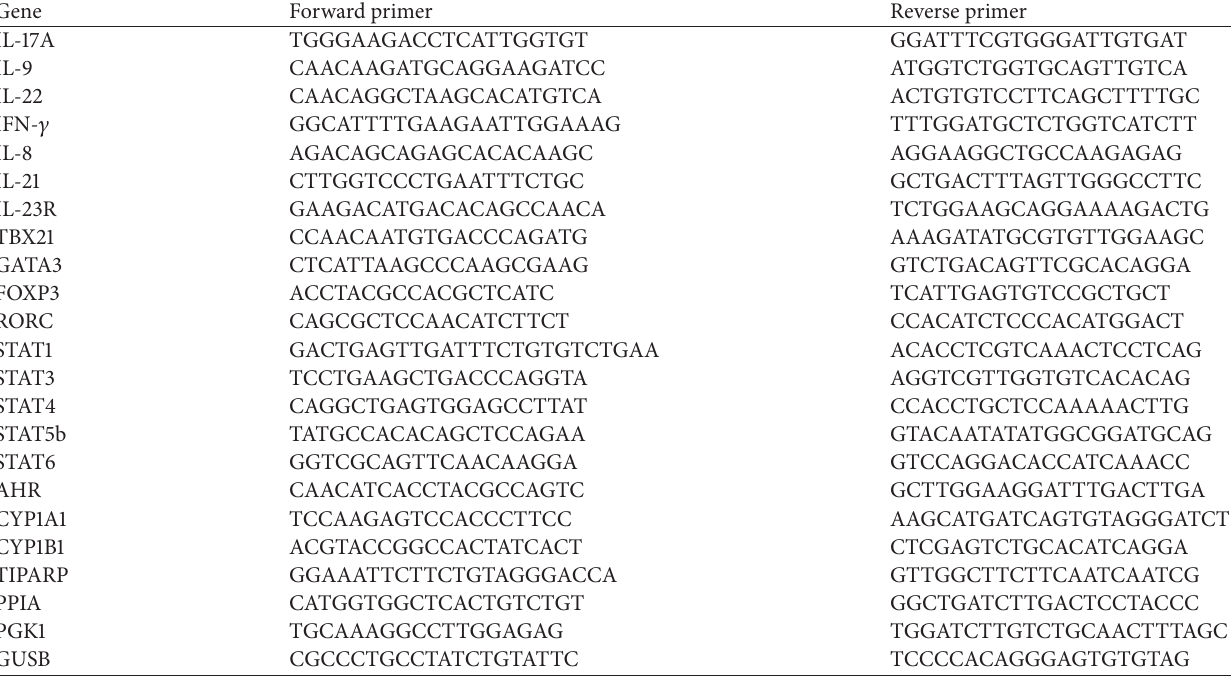
Table 1: Primer pairs for real-time PCR